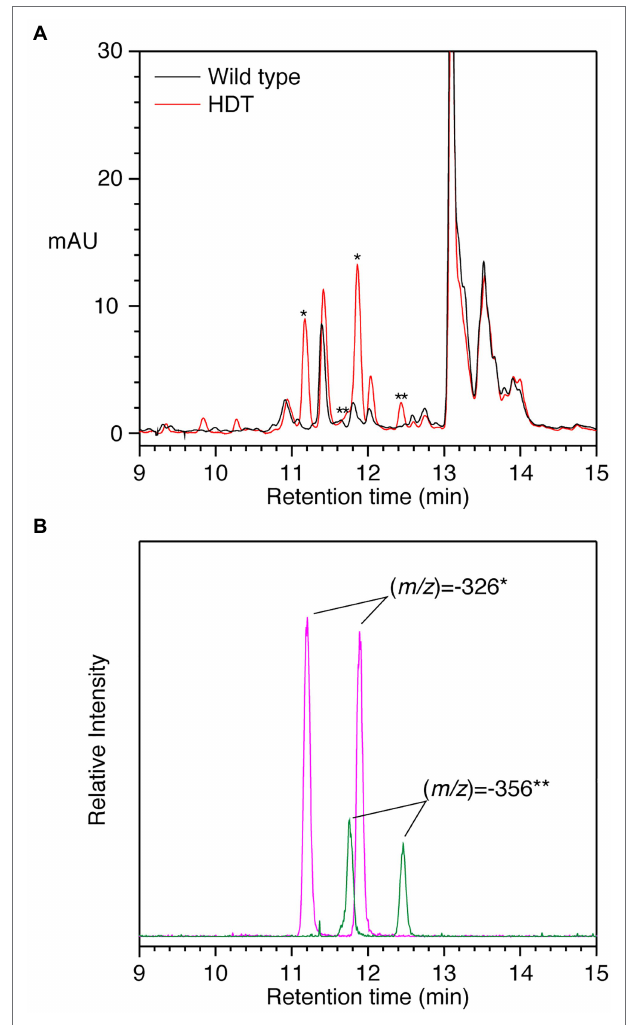
FIGURE 5 | HPLC separation of phenolics from alfalfa transformed with HDT. (A) PDA detection (250–500 nm) of phenolics from wild type (black) or HDT-expressing (red) alfalfa. Asterisks denote peaks present in the transgenic alfalfa with MS signals expected for p -coumaroyl- and feruloyl-L-Tyr, * and **, respectively. (B) Ion selective chromatograms of the transgenic plant phenolic separation shown in Panel A. Signal corresponding to ( m/z ) of − 326 (magenta) and − 356 (green) is shown. These signals were not present in alfalfa transformed with vector only. Amides composed of caffeoyl and L-DOPA moieties were not detected based on MS signals. Retention times are slightly shorter compared to Figures 2 , 4 due to differences in HPLC configuration between the